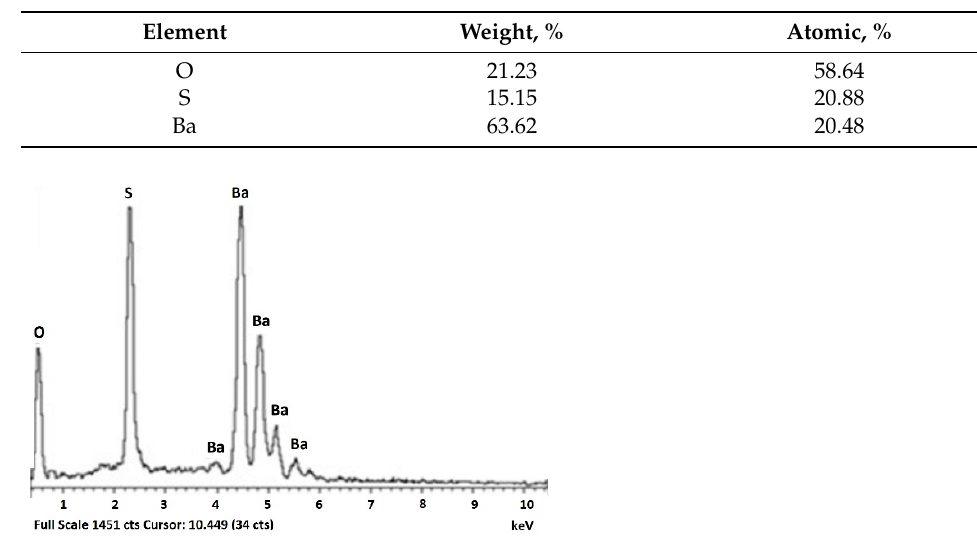
Figure 10. Spectrum and quantification associated with Ba-S-O particles.